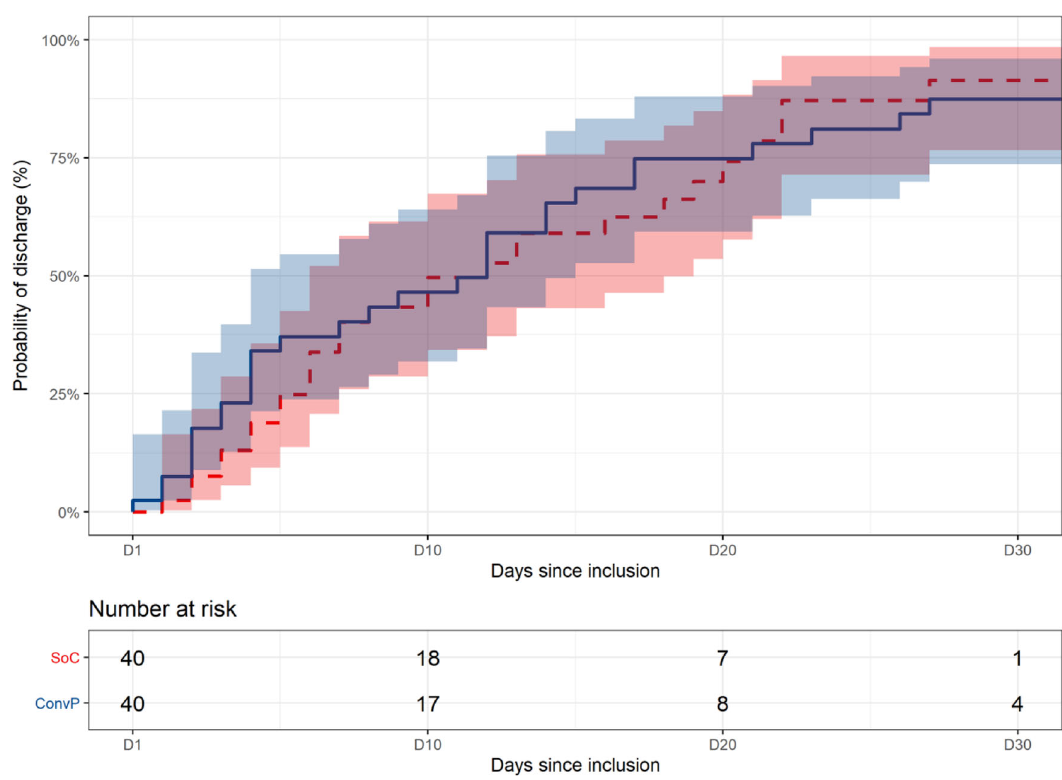
Fig. 2 Kaplan – Meier curves of probability of discharge. Shaded area indicates 95% CI around the Kaplan – Meier estimate of discharge for the two treatment groups (standard of care: red dashed line; convalescent plasma: blue solid line) after enrollment ( D = 1) and table with number of subjects at risk of discharge. Death is not accounted for as competing risk.